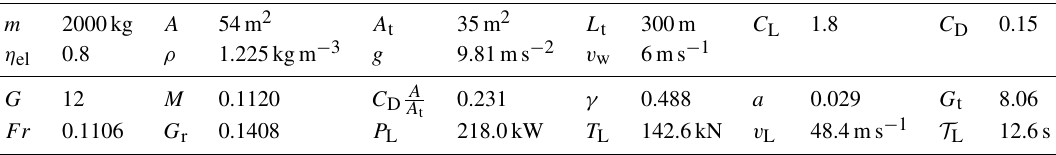
Table 1. Reference values for the examples (values from the Makani MX2 description; Tucker, 2020), associated non-dimensional parameters and quantities evaluated with the steady-state model for γ maximizing Eq. (29).